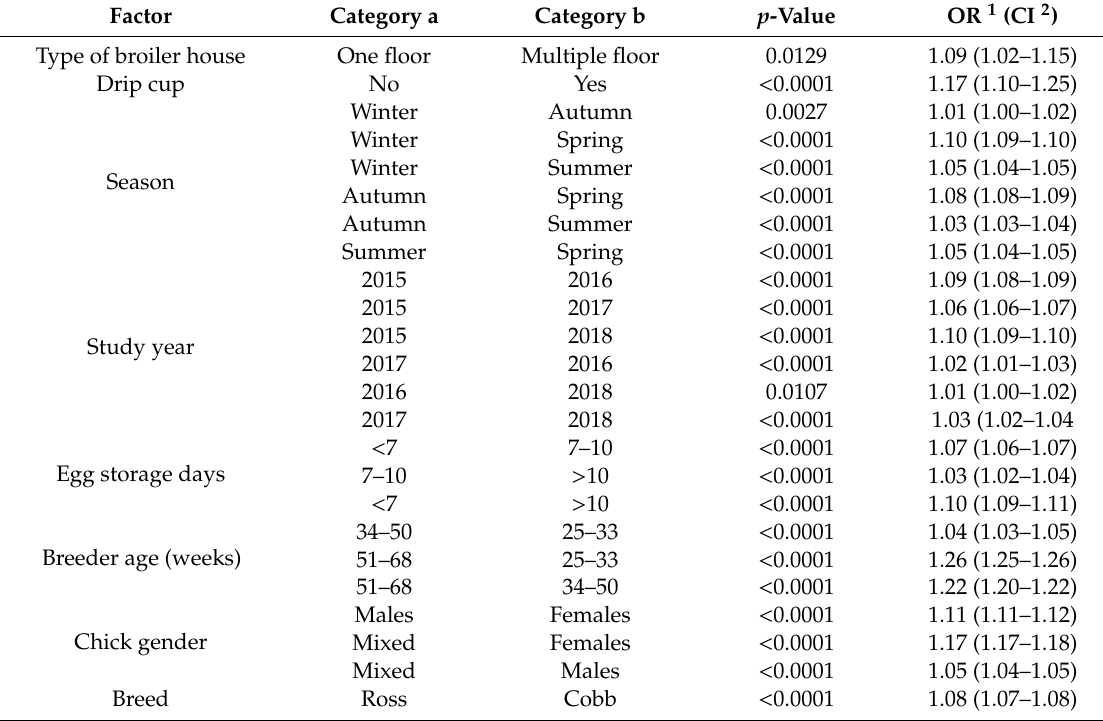
Table 3. The results of the cumulative first-week mortality in the study of 2267 flocks in 104 farms with 253 houses (Spain, 2015–2018) for the di ff erences between each pair of categories of every significant variable (di ff erences were measured in terms of